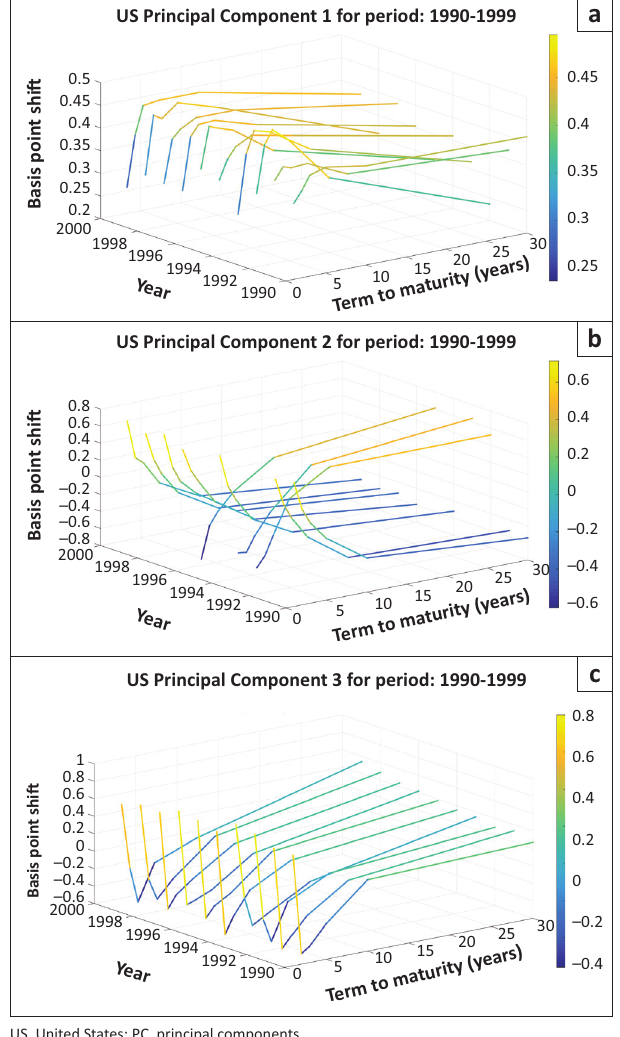
FIGURE 8: Three-dimensional representation of annual US principal components for the period 1990–1999: (a) US annual PC1; (b) US annual PC2; and (c) US annual